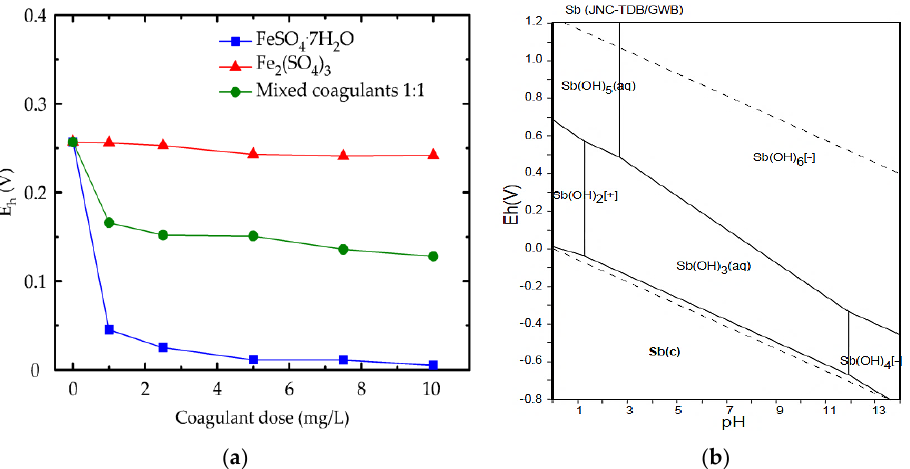
Figure 5. ( a ) Redox potential as a function of coagulant dose (at pH 7 and C o = 50 μg Sb(V)/L), ( b ) Eh-pH diagrams of the system Sb-O-H, according to Geological Survey of Japan Open File Report No. 419